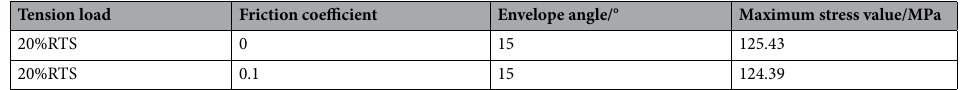
Table 4. Maximum equivalent stress of aluminum strand with or without